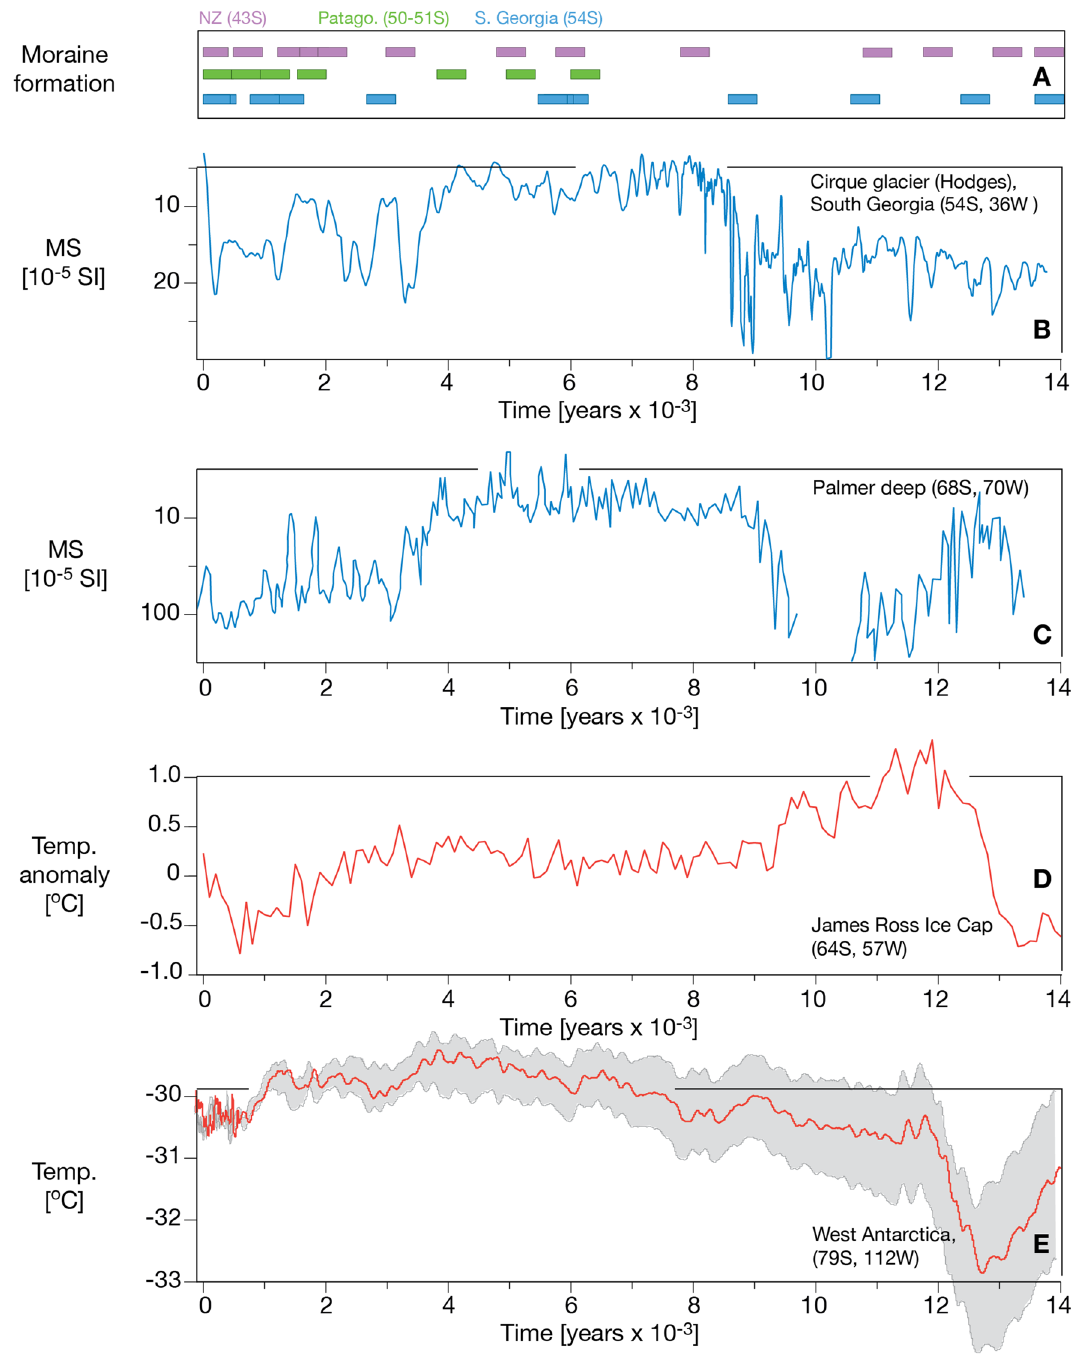
Figure 8. Key records of climate and glacier variability in the circumpolar fringe zone including (from above) a compilation of glacier advances for New Zealand (NZ) 28 , Patagonia in South America 26,30 and data from South Georgia (in this paper). The second panel from the top shows the variability of Hodges Glacier based on the sediment record from Gull Lake (this paper). The third panel shows glacier variability at the Antarctic Peninsula, Palmer Deep 29 . Note that the MS values are reversed for both Hodges Glacier and Palmer Deep. The fourth panel shows the temperature based on an ice core from the James Ross Ice Cap (47), and the last panel from the top shows the temperature as recorded in West Antarctica 33